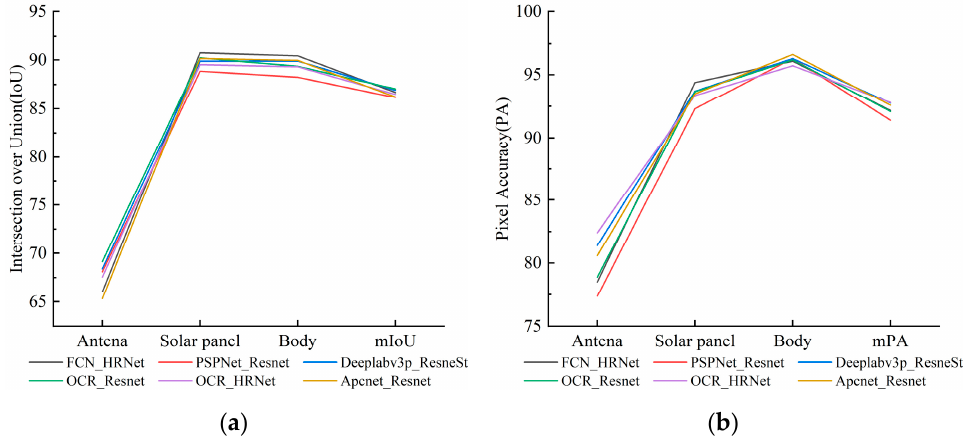
Figure 11. Various types of segmentation accuracy and overall accuracy obtained by training of the spacecraft dataset: ( a ) intersection over union. ( b ); pixel accuracy.